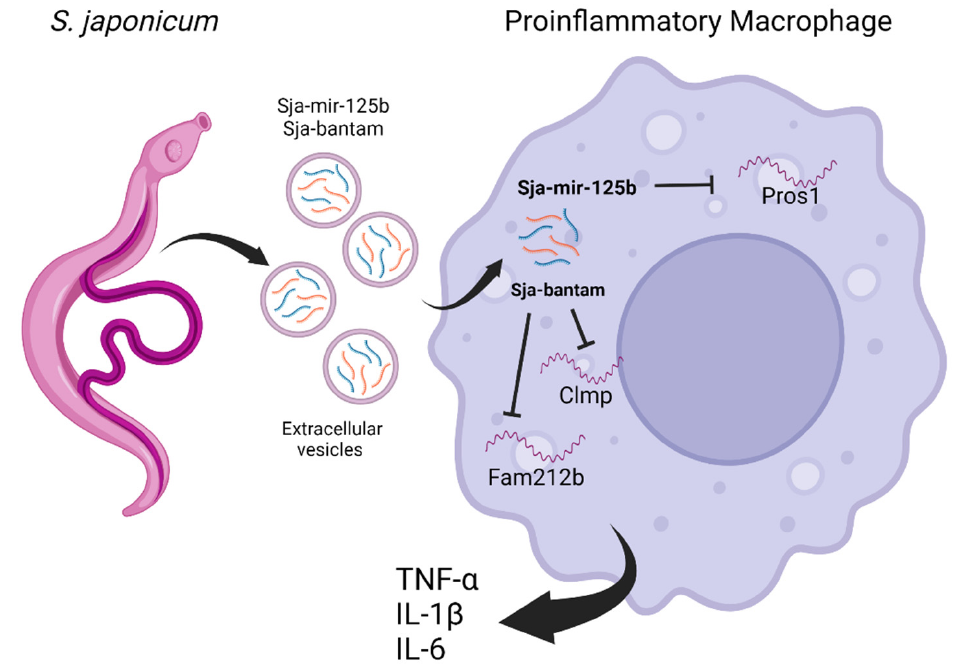
Figure 3. S. japonicum worms can release extracellular vesicles that transport miRNA cargo, such as Sja-mir-125b and Sja-bantam. These miRNAs are internalized by host macrophages, bind molecular targets, and induce a proinflammatory phenotype. Moreover, these miRNAs secreted by the worms promote the proliferation of macrophages. Created using BioRender.com.